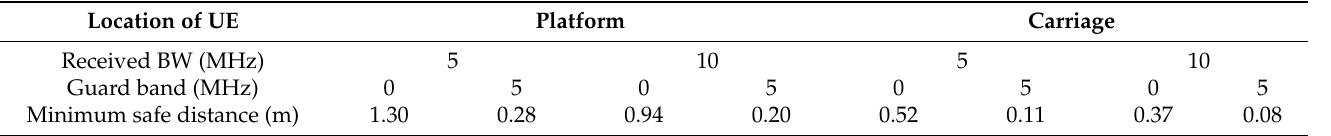
Table 5. LTE FDD UE interfering with LTE-M